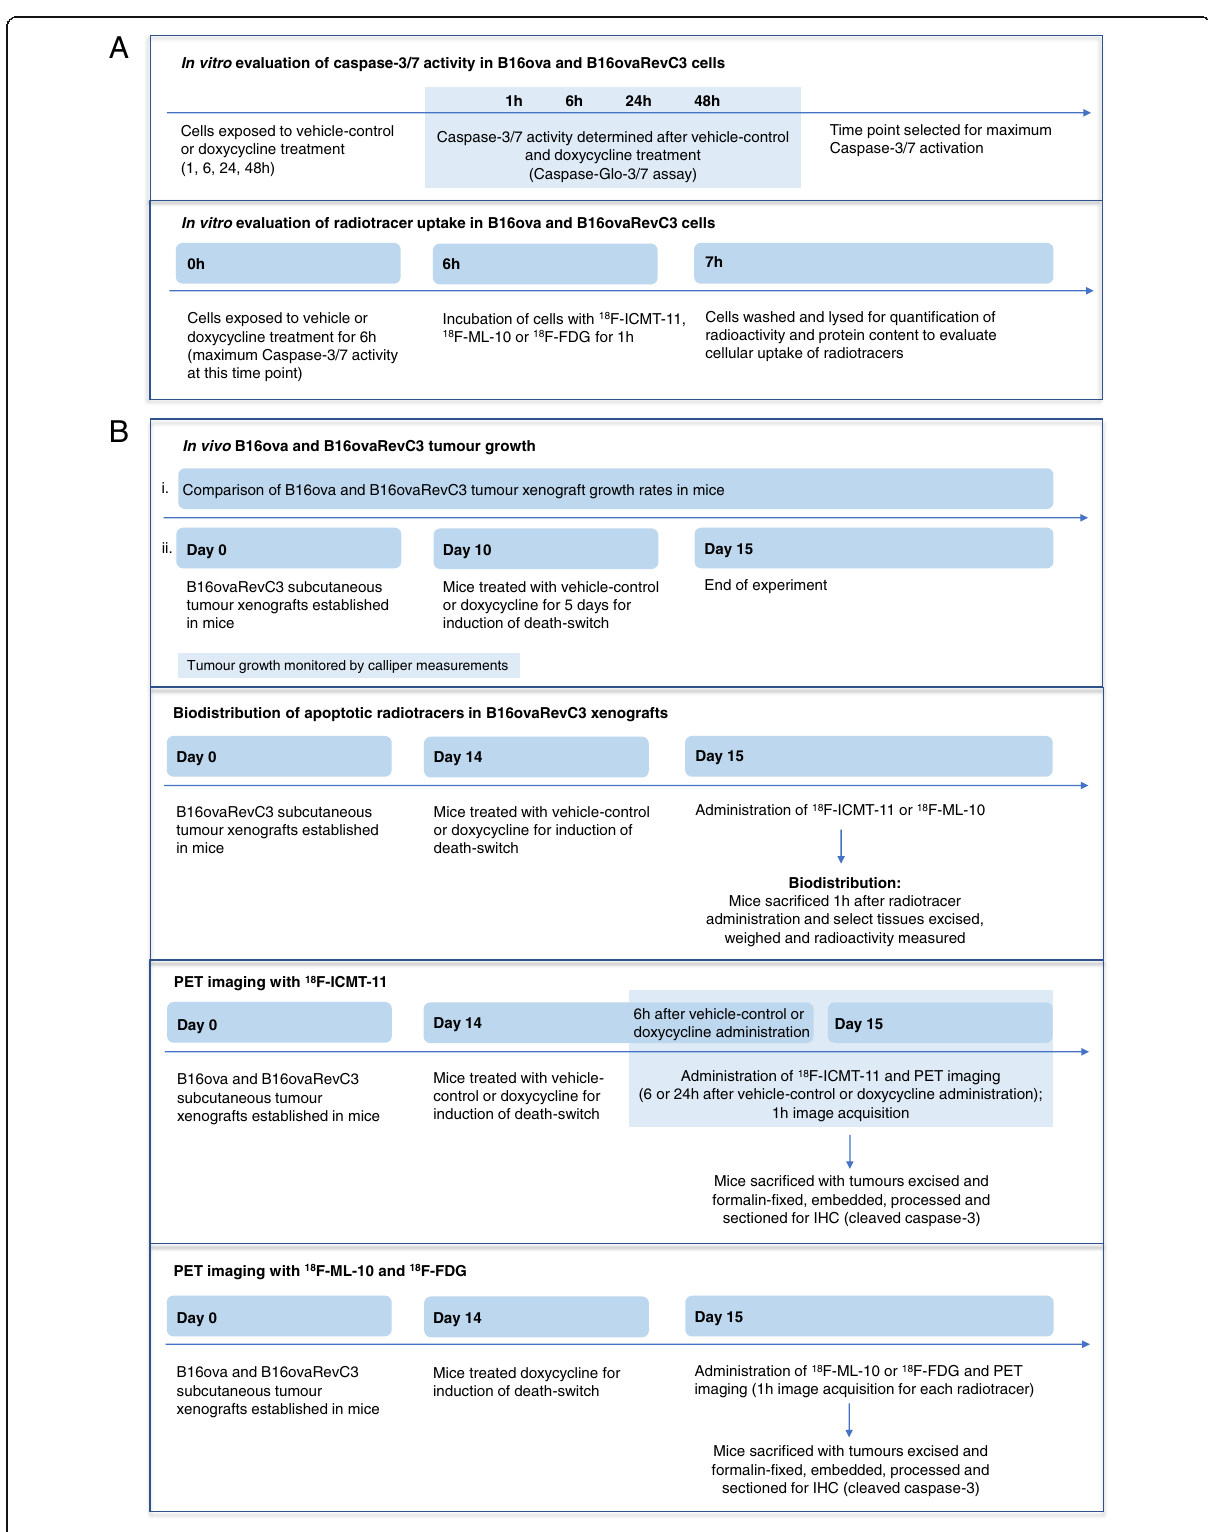
Fig. 1 Experimental paradigm. Overview of a in vitro and b in vivo